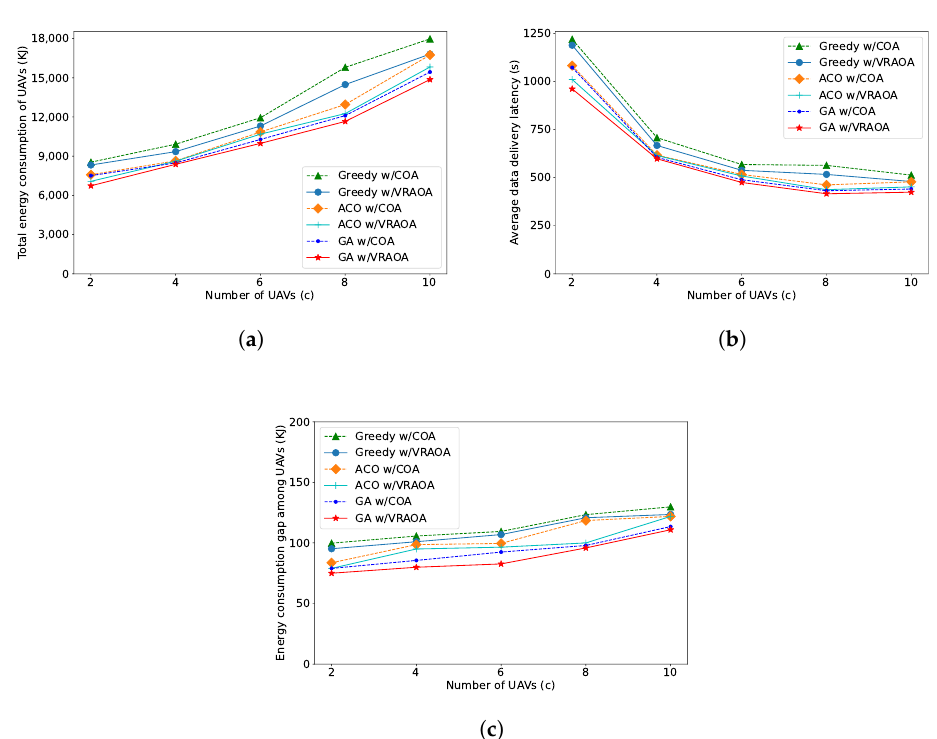
Figure 9. Effects of the number of UAVs: ( a ) effects on the total energy consumption of UAVs, ( b ) effects on average data delivery latency, and ( c ) effects on energy consumption gap (standard deviation) among